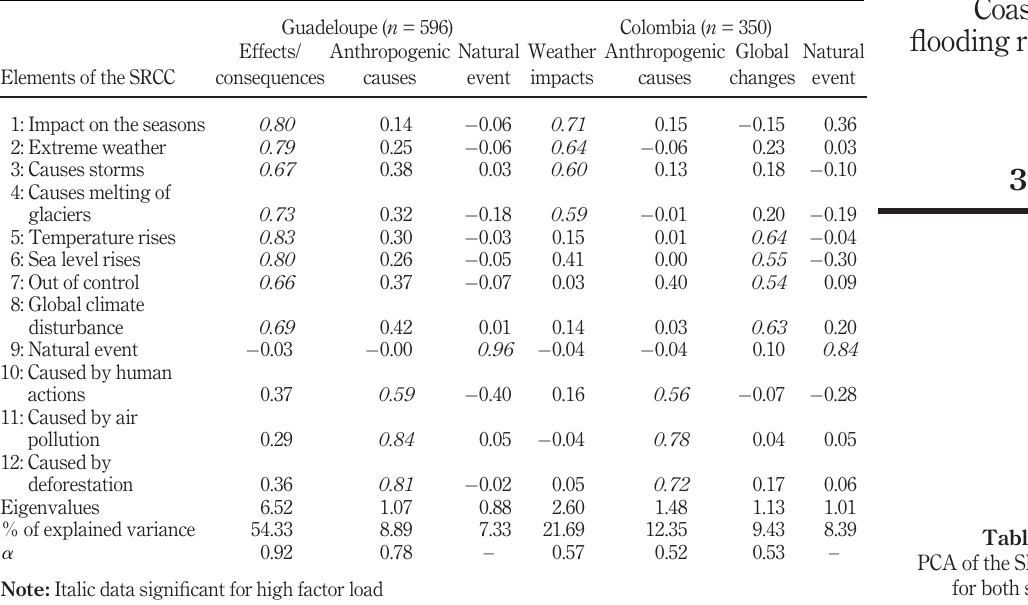
2.1.4.2 Comparison of the principal component factor analysis. Regarding the CPA, the